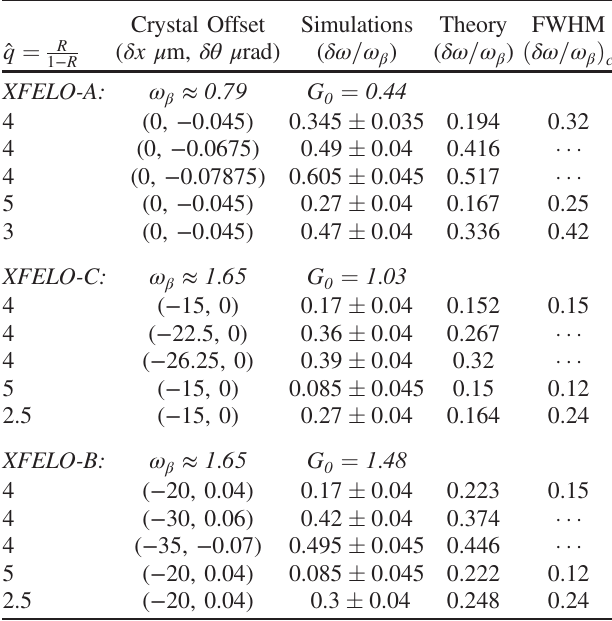
TABLE II. Comparison of resonance widths obtained from simulations and analytical formula of Eqs. (40) and